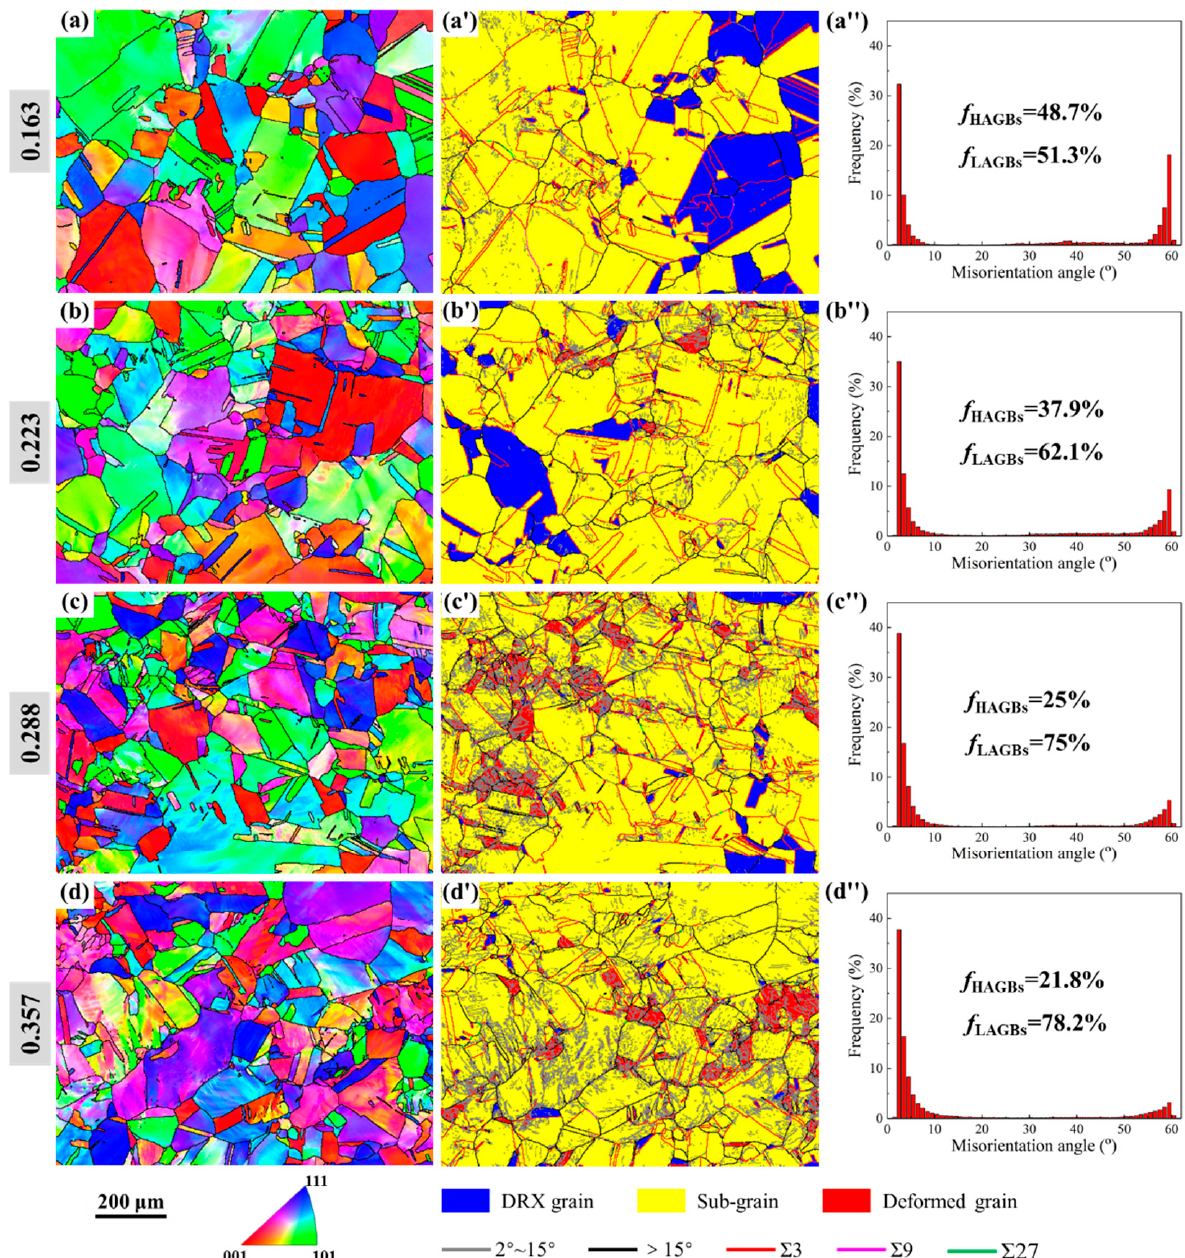
Figure 5. Microstructure characterization results after cold deformation with different strains: 0.163, 0.223, 0.288, and 0.357. ( a – e ) IPF maps; ( a ′ – e ′ ) EBSD maps, highlighting the DRX volume fraction and grain boundary network; ( a ″ – e ″ ) distribution of misorientation angle.